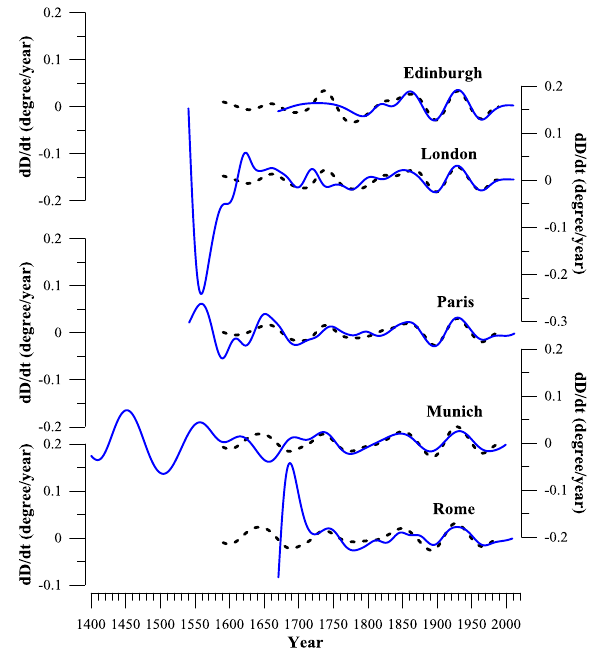
Figure 9. The first time derivative of the HP trend in the data (red) and in the gufm1 (dashed black) for the five locations in Europe.